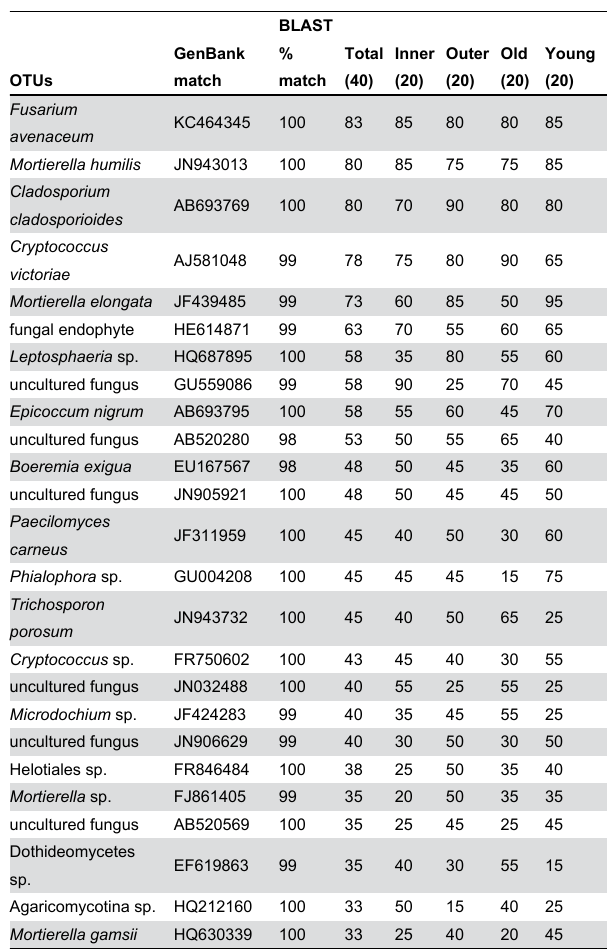
Table 1. The 25 most frequent non-EM OTUs, with respective GenBank match, total percent occurrences, as well as percent occurrences in inner and outer circles, and young and old